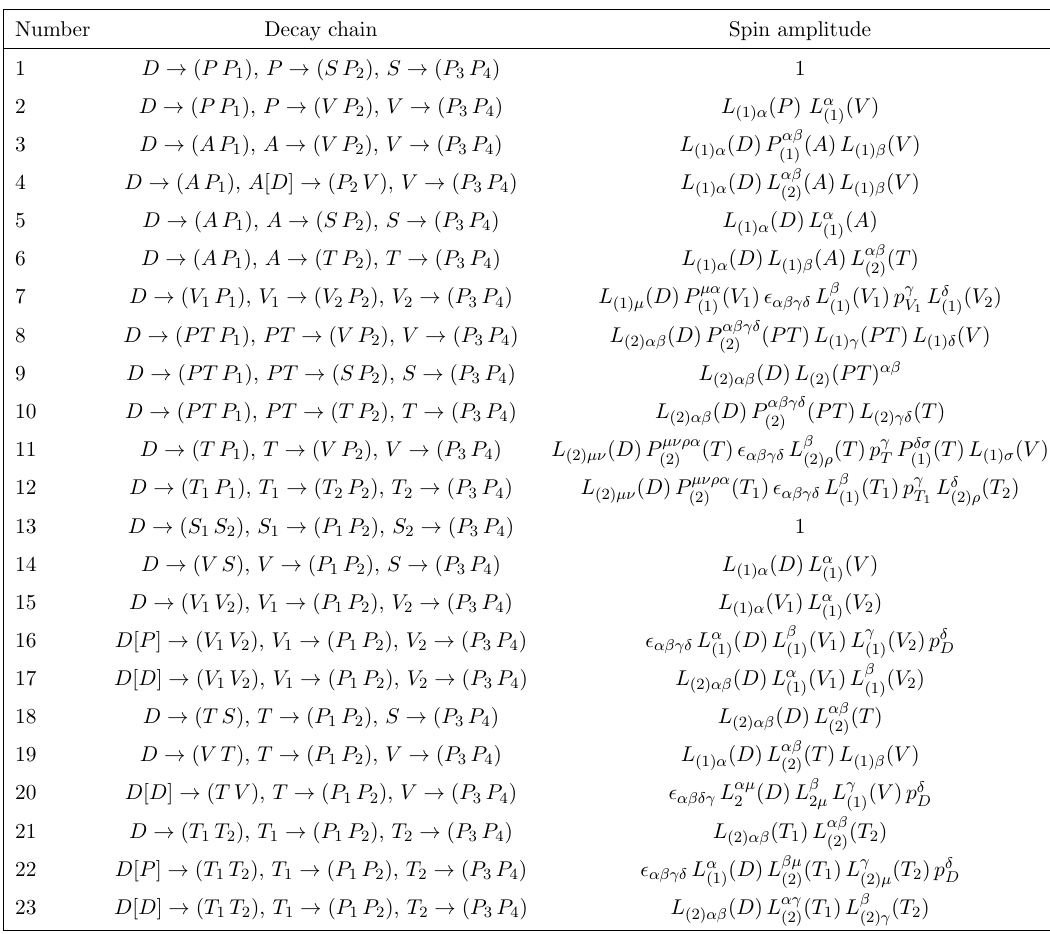
Table 13 . Spin factors for all topologies considered in this analysis. In the decay chains, S , P , V , A , T and PT stand for scalar, pseudoscalar, vector, axial vector, tensor and pseudotensor, respectively. If no angular momentum is speci(cid:12)ed, the lowest angular momentum state compatible with angular momentum conservation and, where appropriate, parity conservation, is